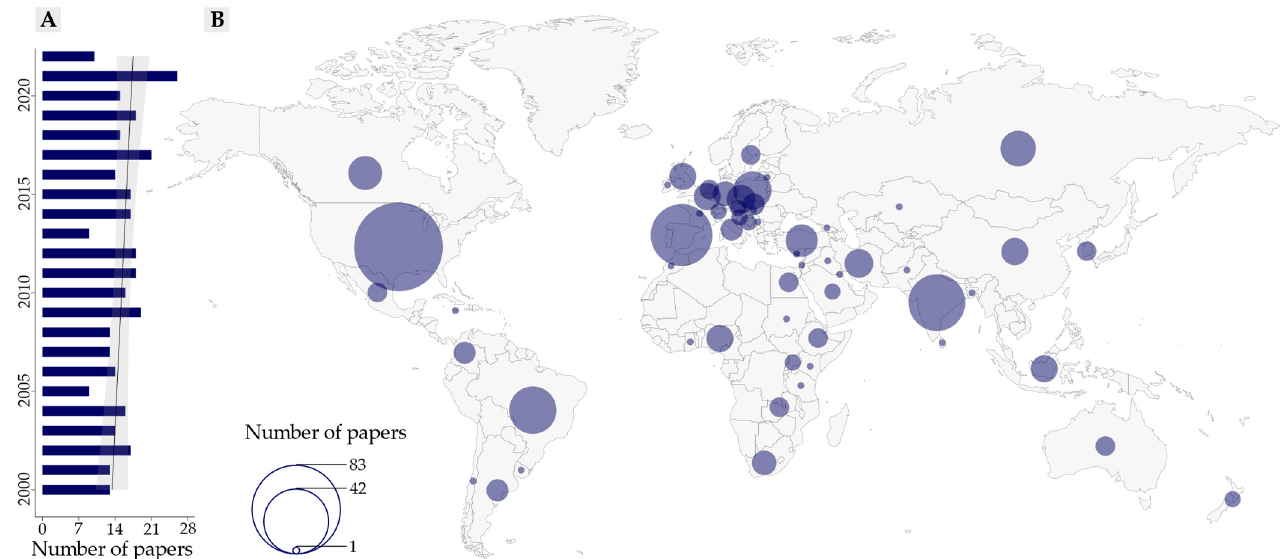
Figure 1. Number of papers concerning trace elements in beef cattle production published in the period 2000–2022: ( A ) bar plot and trend line, with confidence interval (shaded area) for papers published by year, between 2000 and 2022; data referring to 2022 were obtained up to 1 July 2022 and adjusted to the 12-month period by multiplying by 2; ( B ) map showing the number of papers published in different countries.